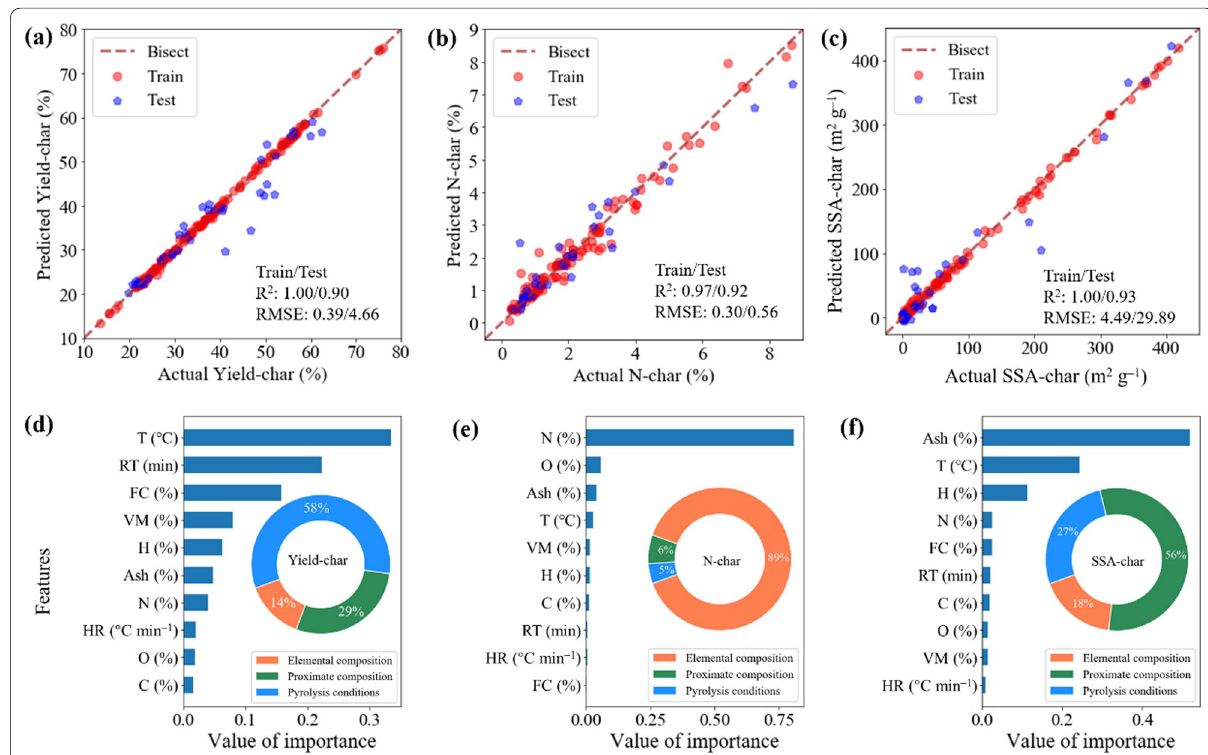
Fig. 4 Single-target prediction figures of a Yield-char, b N-char, and c SSA-char, and the relative contribution of each feature for d Yield-char, e N-char, and f SSA-char based on GBR model (( a and d ), ( b and e ), ( c and f ) from dataset #1_5, #2_5, and #3_5,